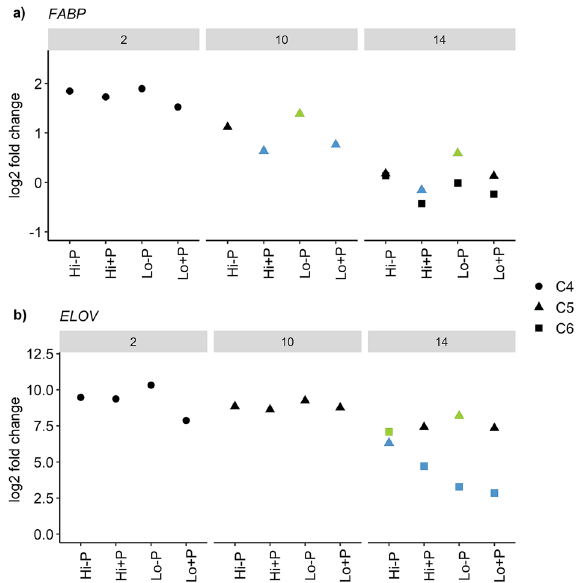
Figure 2. Gene expression of ( a ) fatty acid binding protein ( FABP ) and ( b ) fatty acid elongase ( ELOV ) in Calanus finmarchicus copepods exposed to a combination of presence or absence of a predator cue with high or low food availability, compared to the reference group ( Calanus spp. C5 copepodites in diapause). Bar at the top indicates the number of days between experimental initiation and sampling. Within each day and stage, green symbols denote significant (P < 0.05) upregulation from blue symbols between treatments. Shapes indicate developmental stages (see legend). X-axis shows treatments: Hi-P High food and no predator cue, Hi + P High food and predator cue, Lo-P Low food and no predator cue, Lo + P Low food and predator cue. Y-axis shows log2 fold change (FC) relative to the reference group. Not marked in figure: in C6, ELOV was significantly upregulated in Hi + P relative to Lo + P (details in